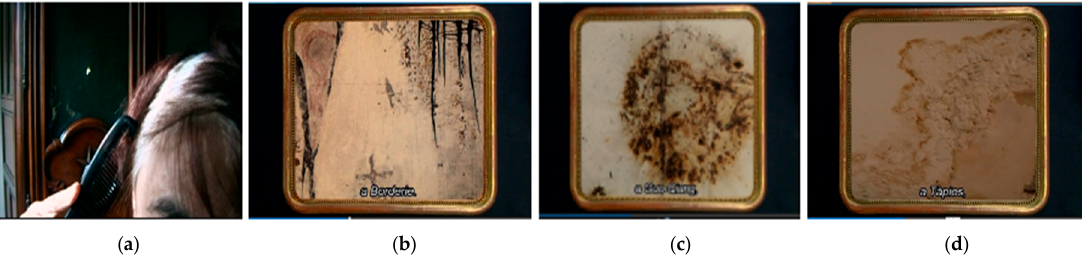
Figure 8. ( a ) Varda’s focus on signs of ageing; ( b – d ) Damps stains on the walls and ceiling of her apartment which she imagines as works of art of established artists.